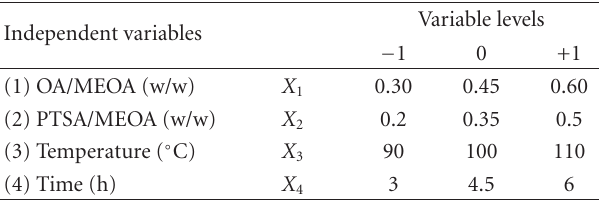
Table 1: Independent variables and their levels for D-optimal de- sign of the oxirane ring opening